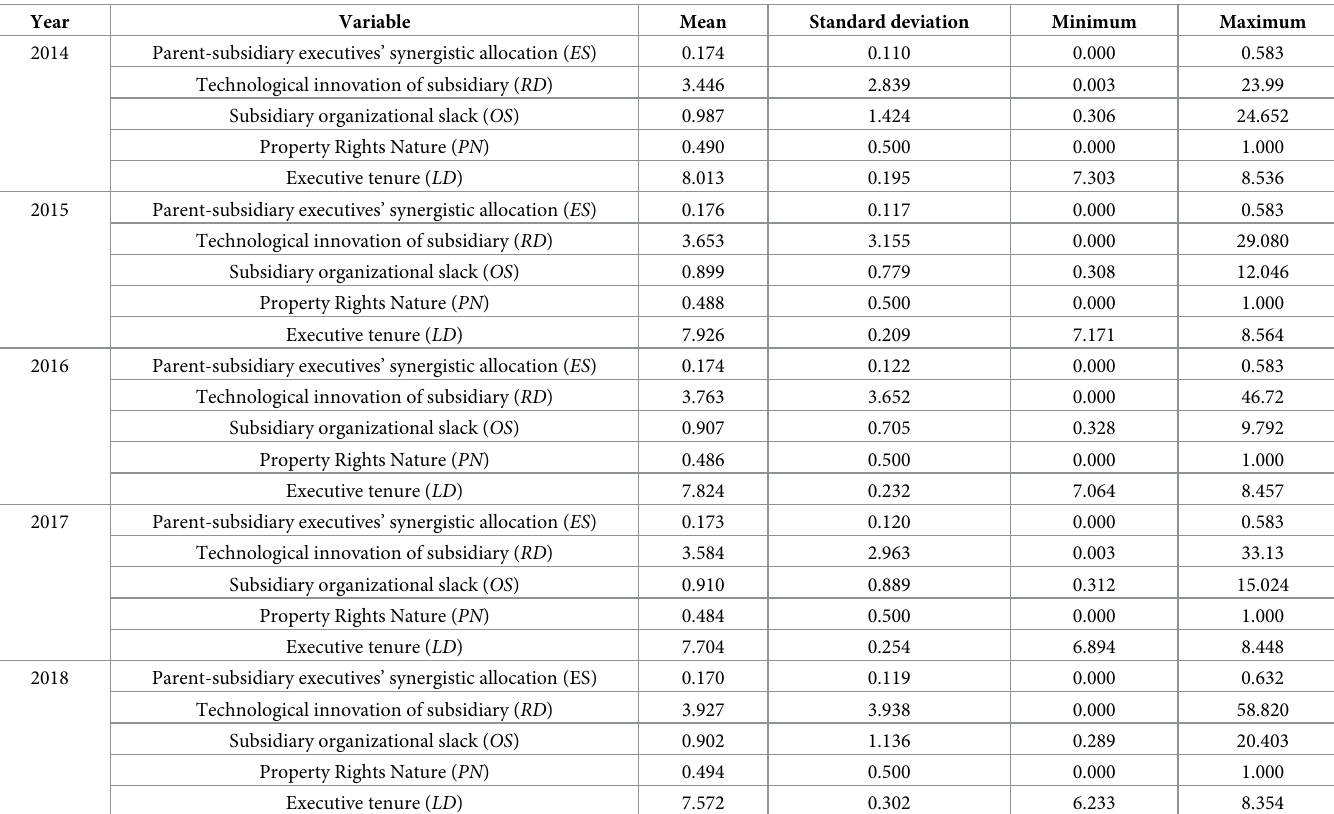
Table 3. Results of descriptive statistical